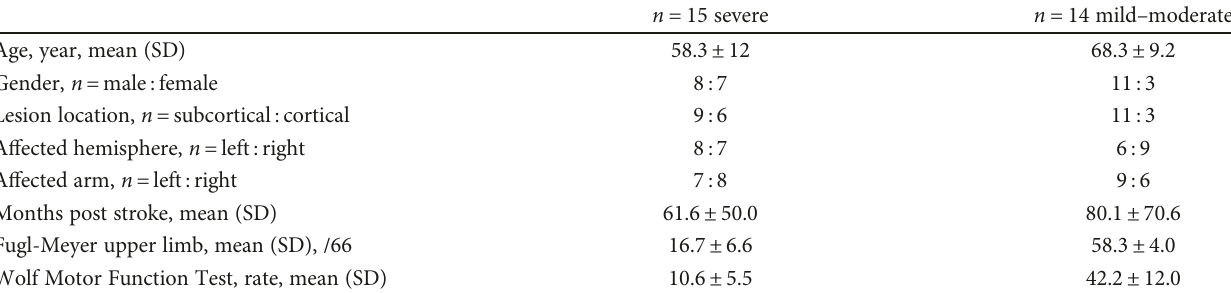
Table 1: Summary of group demographics and stroke